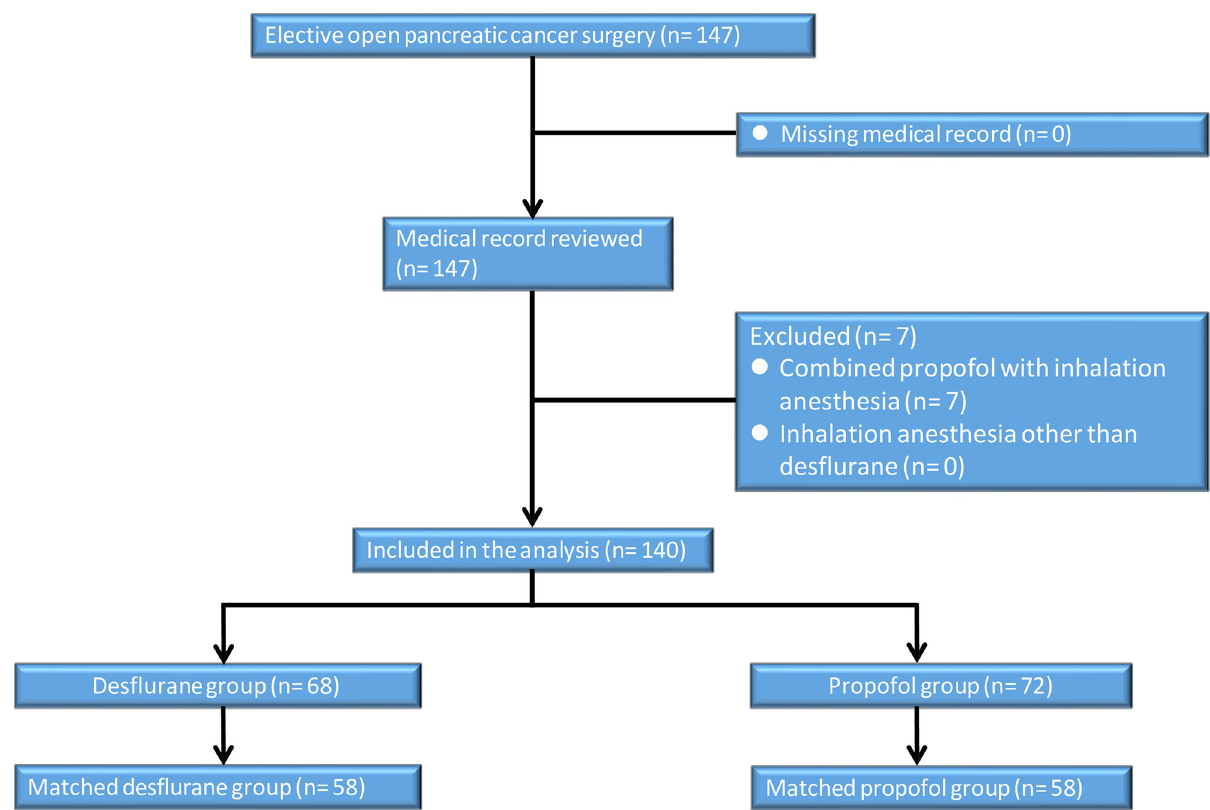
Fig 1. Flow diagram detailing the selection of patients included in the retrospective analysis. 7 patients were excluded due to combined propofol anesthesia with inhalation anesthesia or regional analgesia, incomplete data, age < 20 years, and laparoscopic surgery.